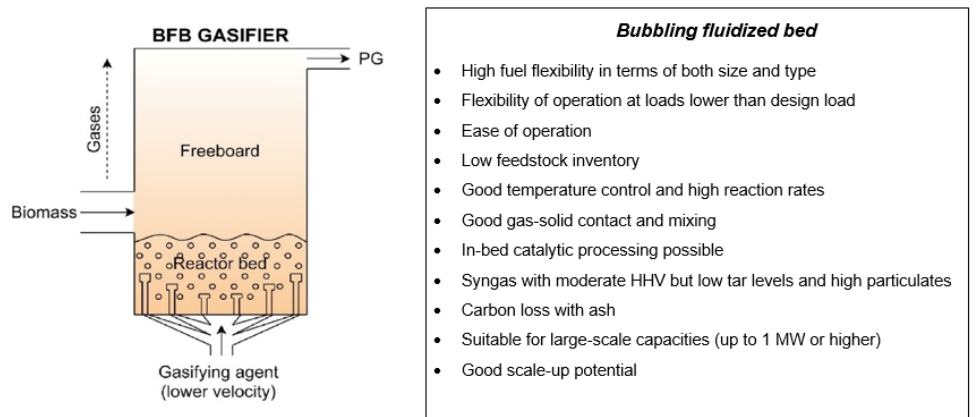
Figure 4. Schematic representation and features of a BFB gasifier. Reproduced with permission from Elsevier [34].